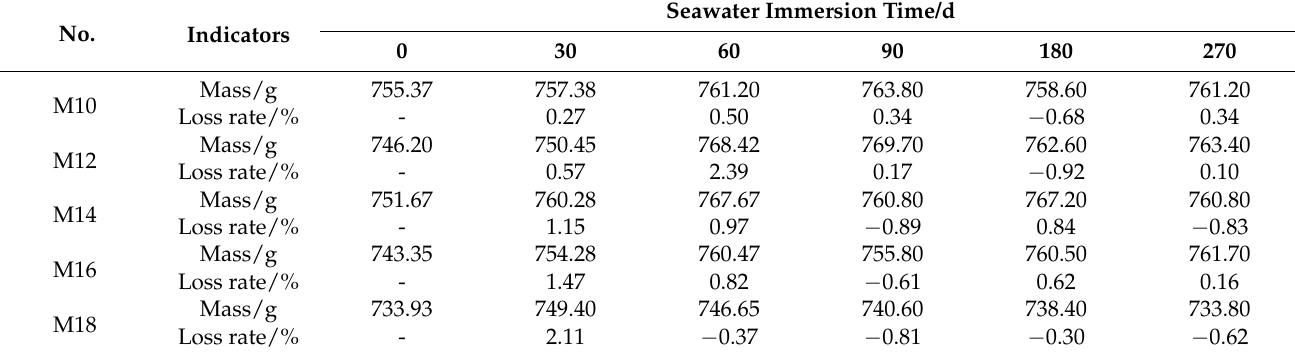
Table 9. Mass change of Group